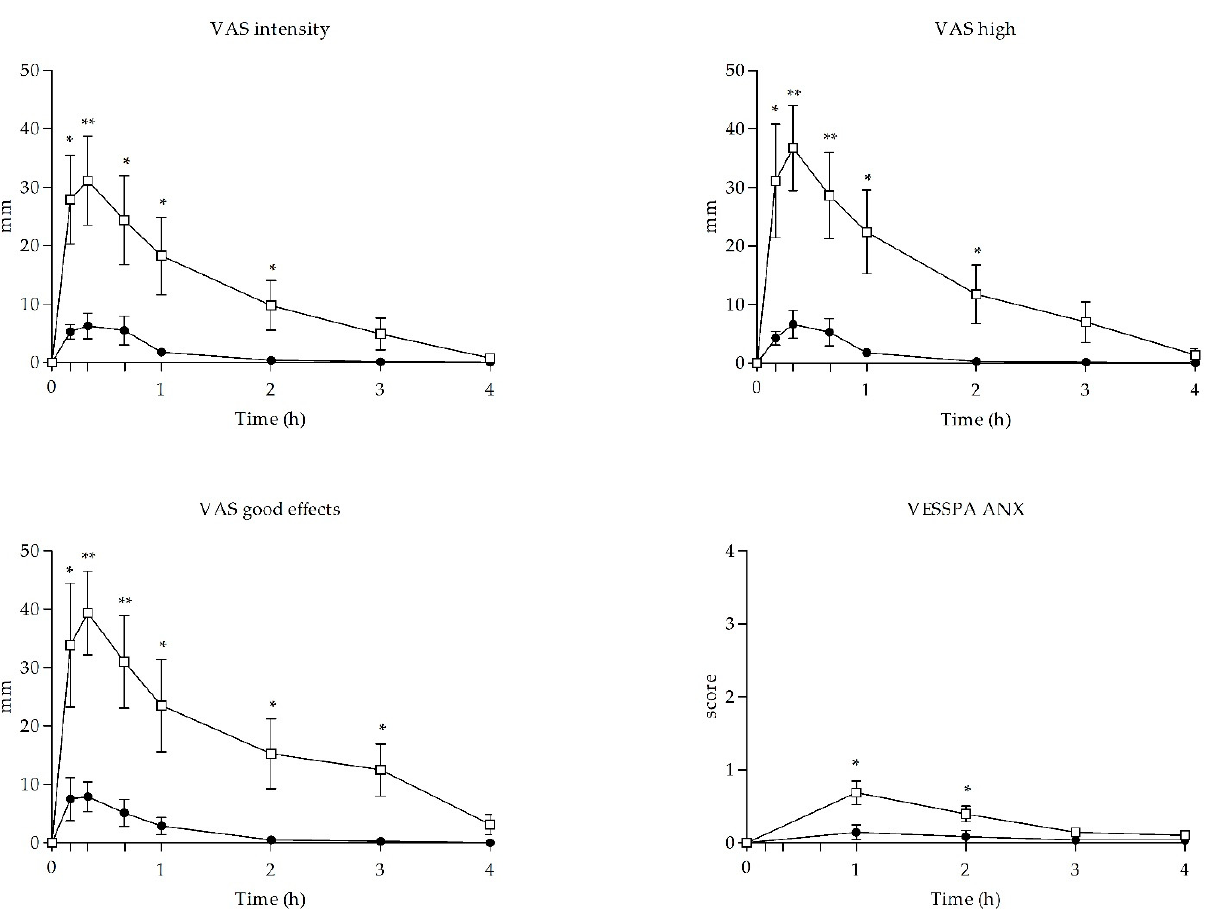
Figure 2. Time course of subjective effects observed after self-administration of UR-144 ( n = 8) and THC ( n = 8). Values are differences from baseline. Symbols: ● UR-144, □ THC; values are mean and standard error. SBP = systolic blood pressure; HR = heart rate. * statistically significant a p < 0.05; ** statistically significant a p < 0.01.